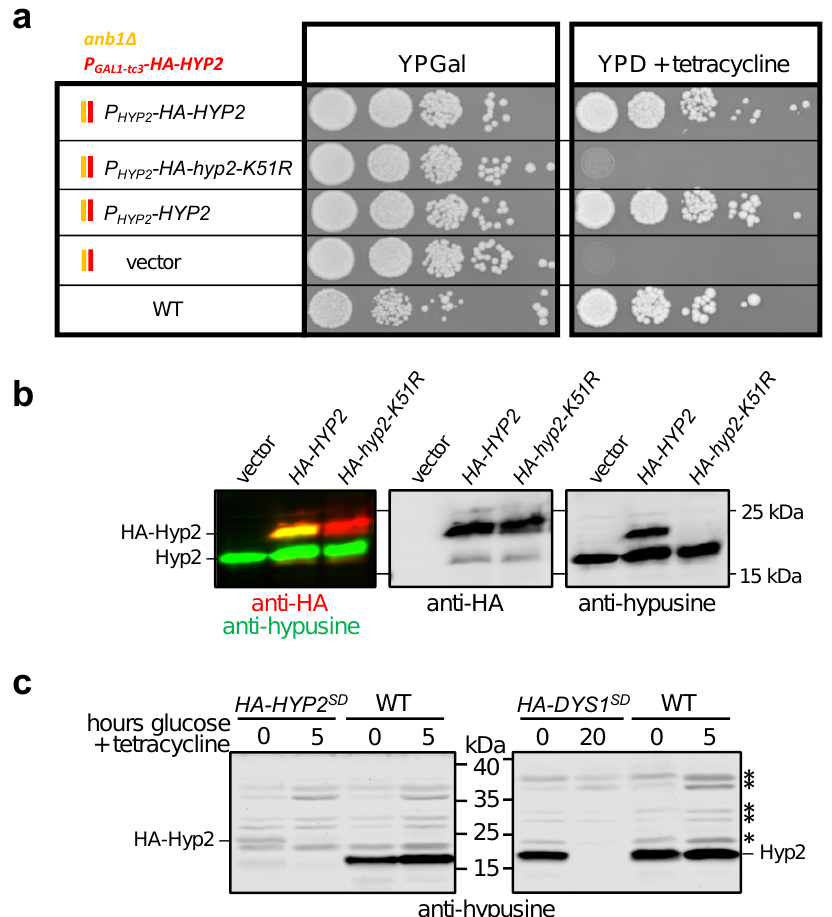
Figure 3. Analysis of hypusinated Hyp2. ( a ) Shown is a spot assay of serial dilutions (1:10) of an anb1 ∆ HYP2 -SD strain transformed either with an empty CEN/LEU2 vector, or the same vector expressing untagged HYP2 , HA-HYP2 , or HA-hyp2-K51R . The latter encodes a mutant version of Hyp2 lacking lysine 51, the site of hypusination. Transformants were selected on galactose media lacking leucine and then spotted on the indicated media. Pictures were taken after 3 days of incubation at 30 °C. ( b ) Simultaneous anti-HA (red) and anti-hypusine (green) western blot analysis of extracts from a wild-type strain transformed either with an empty vector or the same vector encoding HA-HYP2 or HA-hyp2-K51R (left panel). The middle and right panels show the individual signals in grayscale. ( c ) Shown is an anti-hypusine western blot analysis to monitor the disappearance of hypusinated Hyp2 after shutting down expression of either HYP2 ( HYP2 -SD) for 5 h, or DYS1 ( DYS1 -SD deg ) for 20 h, by growing the cells in YPD with 250 µM tetracycline. A congenic wild-type strain was treated the same way for 5 h. *, non-specific bands.